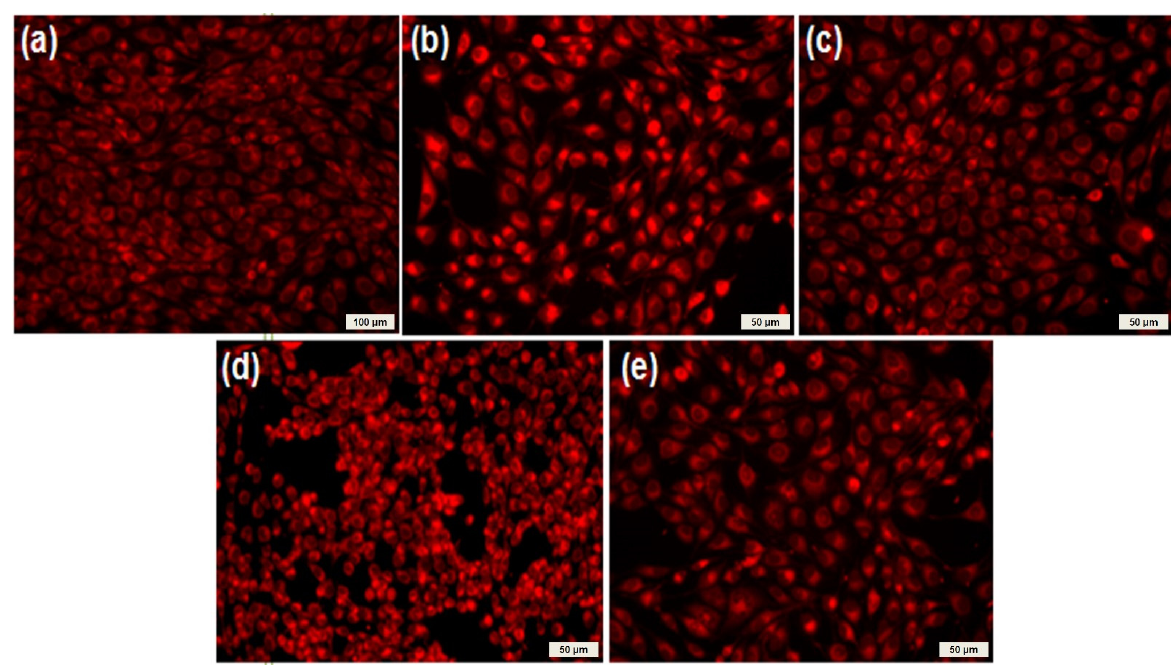
Figure 10. Microscopy images of human endothelial cells developed at 72 h on the surface of ( a ) glass control and ( b ) CF/PVP/FL, ( c ) PVP/FL, ( d ) CEFTRI/PVP/FW, and ( e ) PVP/FW MAPLE-deposited thin films. Viable endothelial cells were stained in red by Vital Cell tracker RED CMTPX fluorophore, showing that they are viable, with a normal morphology and adherence